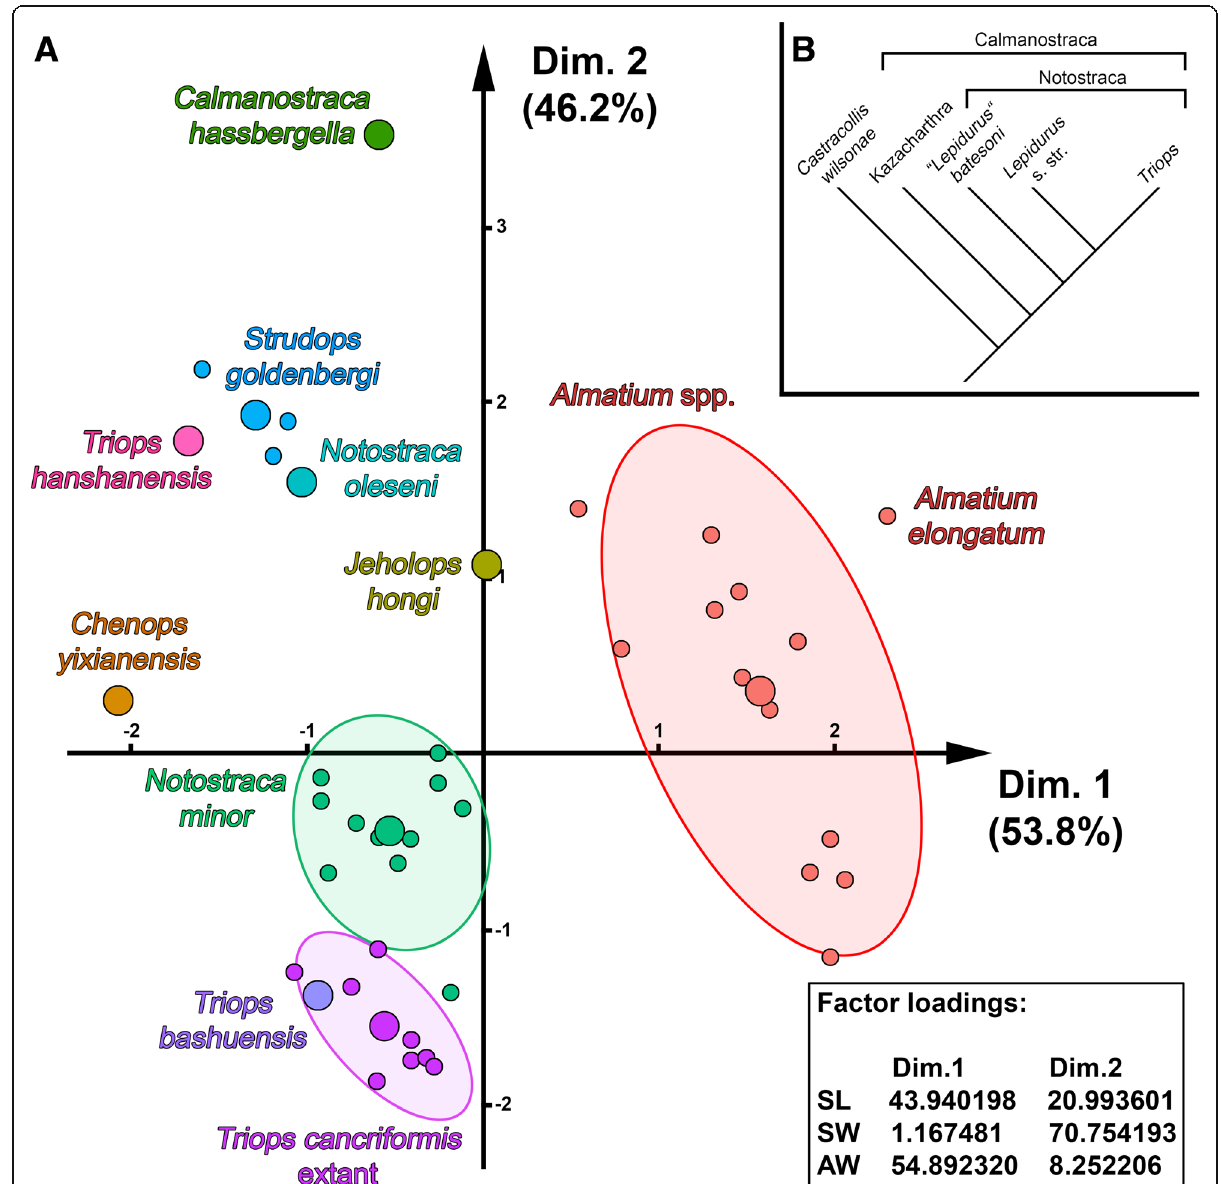
Fig. 4 Morphospace using Burnaby-Back-Projection and its resulting implications: a Morphospace using Burnaby-Size-Correction and PCA, small circles represent included specimens, large circles represent the center calculated for the respective species, ellipses indicate a 75% confidence interval; b Simplified phylogenetic tree of Calmanostraca. Castracollis wilsonae was used to root the tree. Kazacharthra as sister group to Notostraca. A distinction is made between Lepidurus batesoni and Lepidurus s. str. (including all other species of Lepidurus ) because the first one does not show a modified and elongated first thoracic appendage in contrast to Lepidurus s. str. and Triops